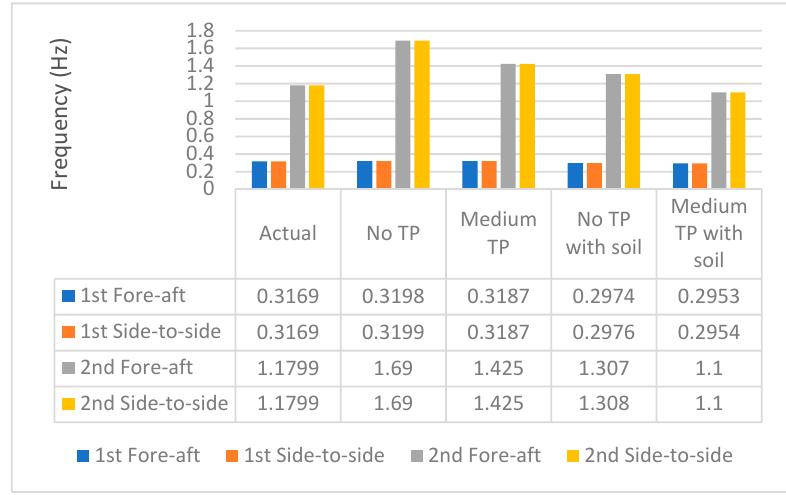
Figure 16. Effect of transition piece on the dynamic response.